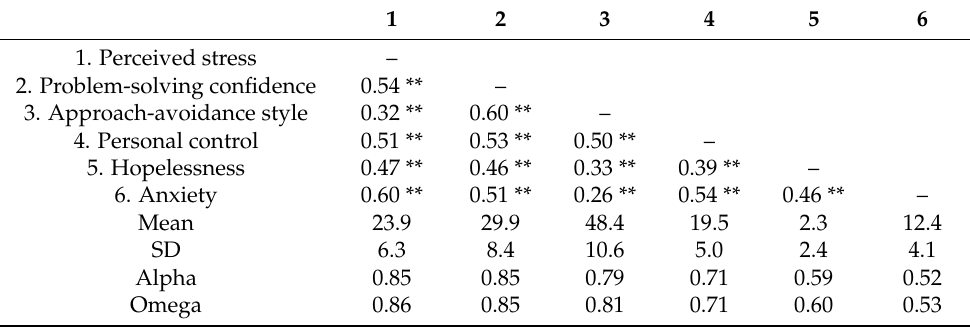
Table 1. Intercorrelations, descriptive statistics, and